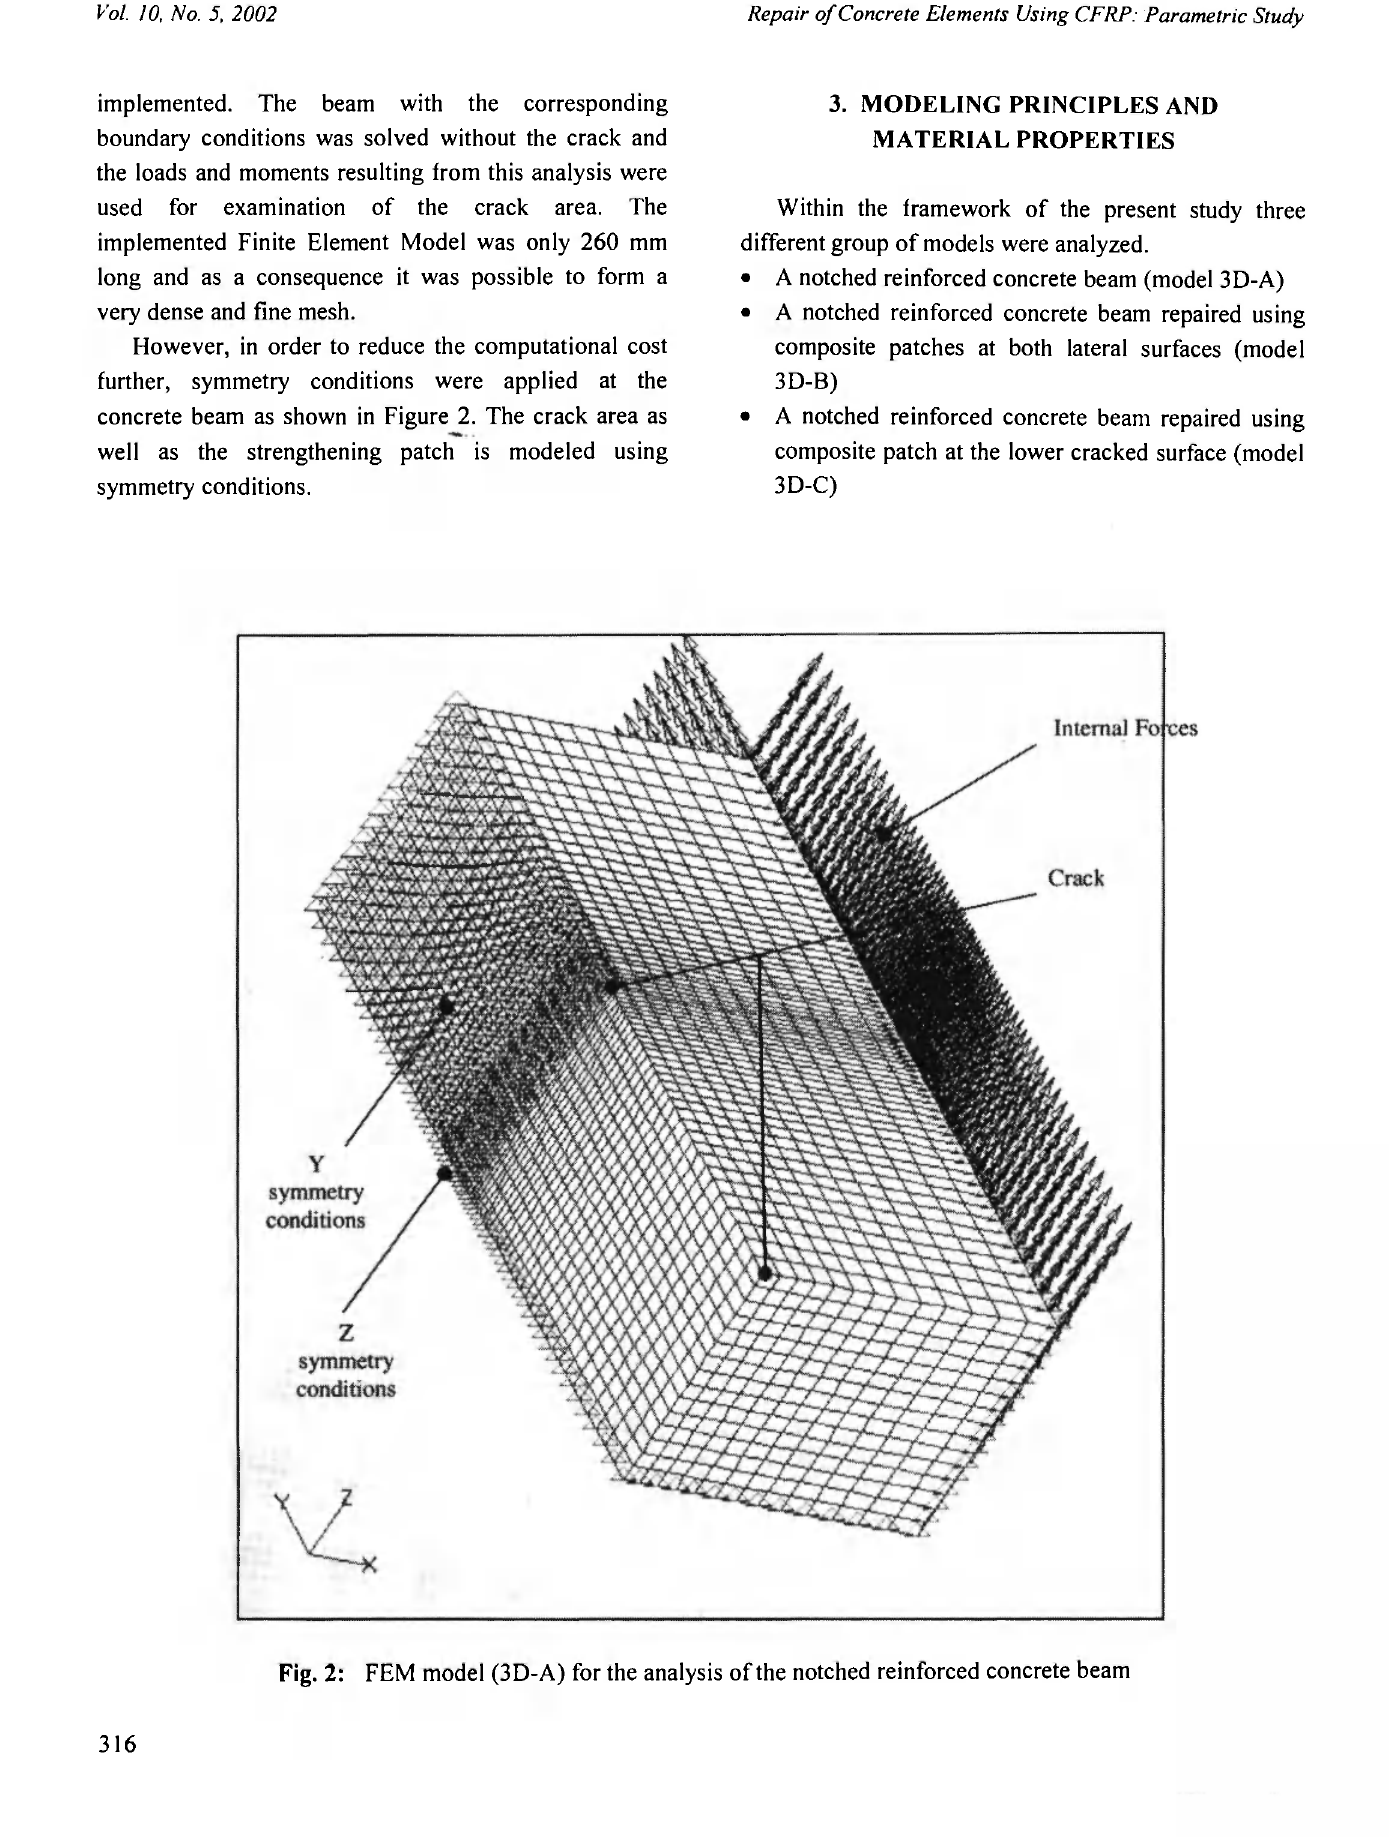
Fig. 2: FEM model (3D-A) for the analysis of the notched reinforced concrete